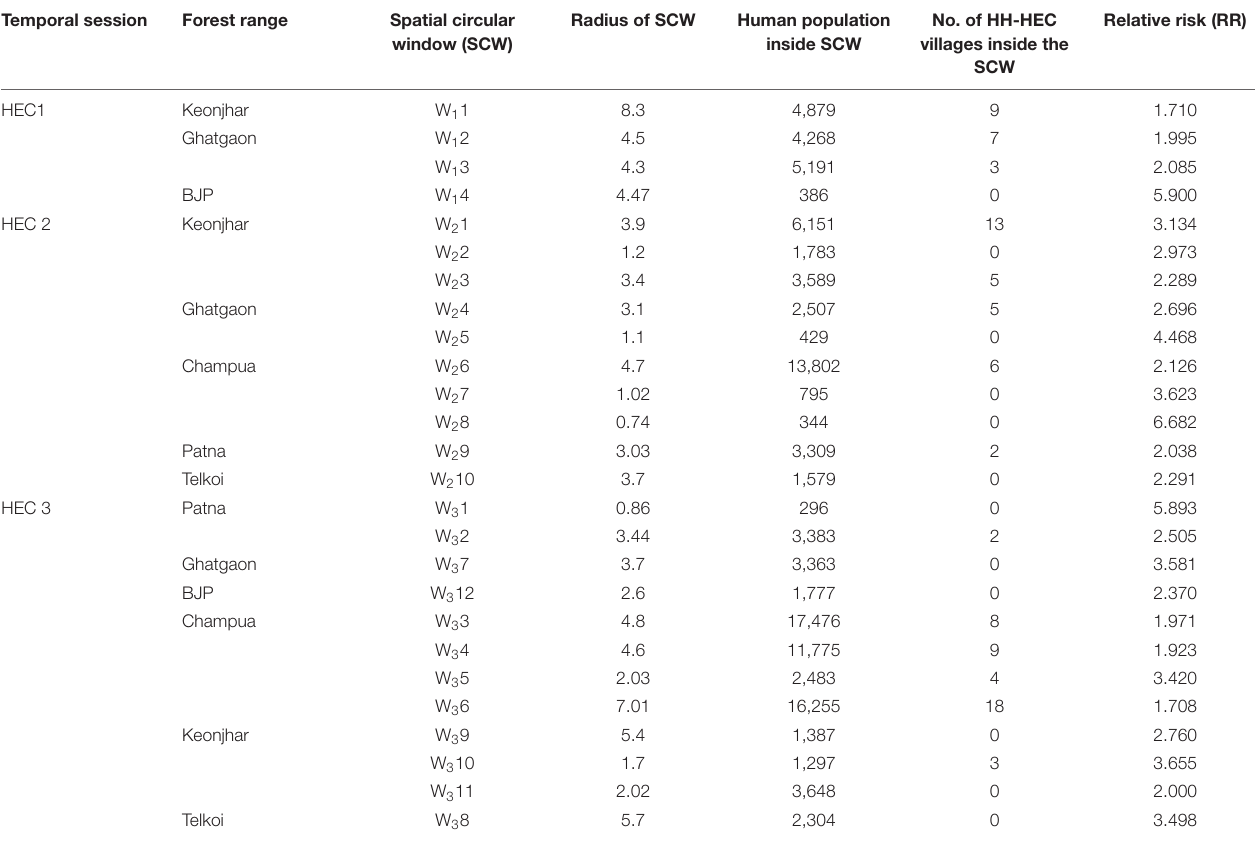
TABLE 2 | Table showing the results from the Kulldorff’s spatial scan statistics performed in SatScan and the HH-HEC villages inside each SCW. Temporal session Forest range Spatial circular